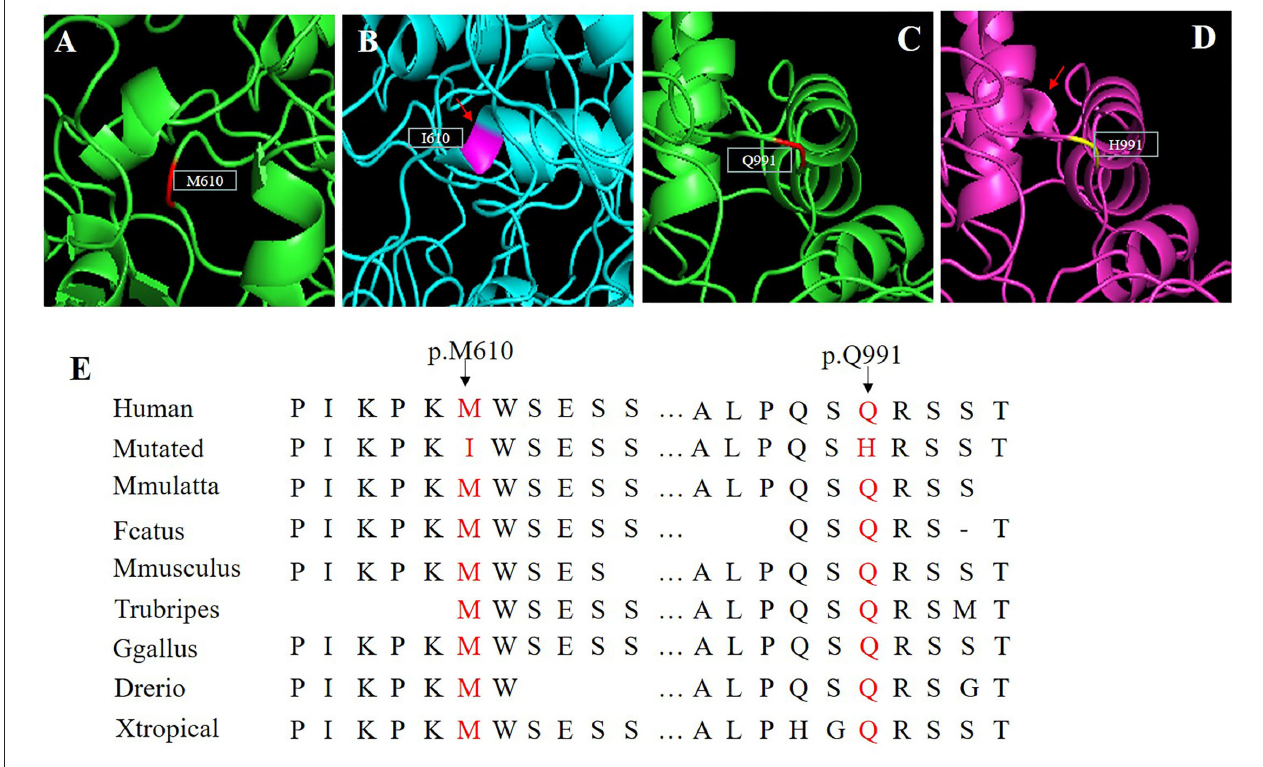
FIGURE 2 | (A–D) Protein molecular models of wild type (upper) and FRMD4A mutations (lower) by I-TASSER. (E) Conservation analysis of the abnormal variation. Results indicate that both Met610 and Gln991 in the FRMD4A protein are highly conserved between different